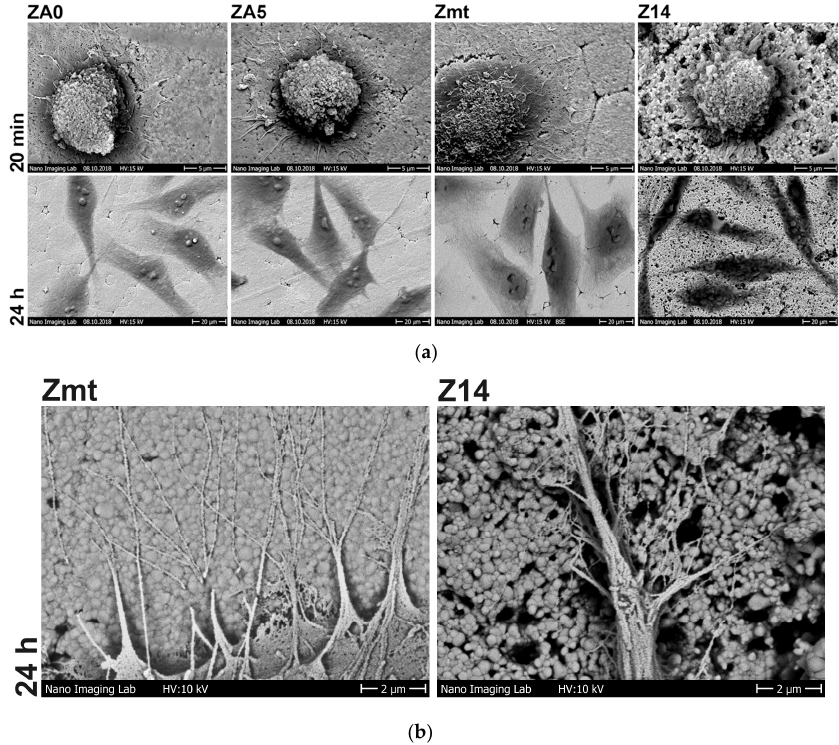
Figure 4. ( a ) MG-63 cells on differently treated zirconia surfaces. First row: spreading after 20 min (SEM, 5000×, bar 5 µm); second row: spreading after 24 h (SEM, 1000×, bar 20 µm). ( b ) MG-63 cell filopodia formation and interaction with the substrates Zmt and the micro-structured endosseous surface of a zirconia implant (Z14) (SEM, 10,000×, bar 2 µm).